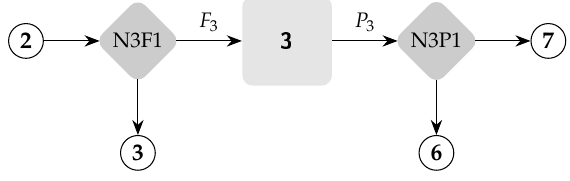
Figure 2. Productive structure graph of the TGAS turbine process.